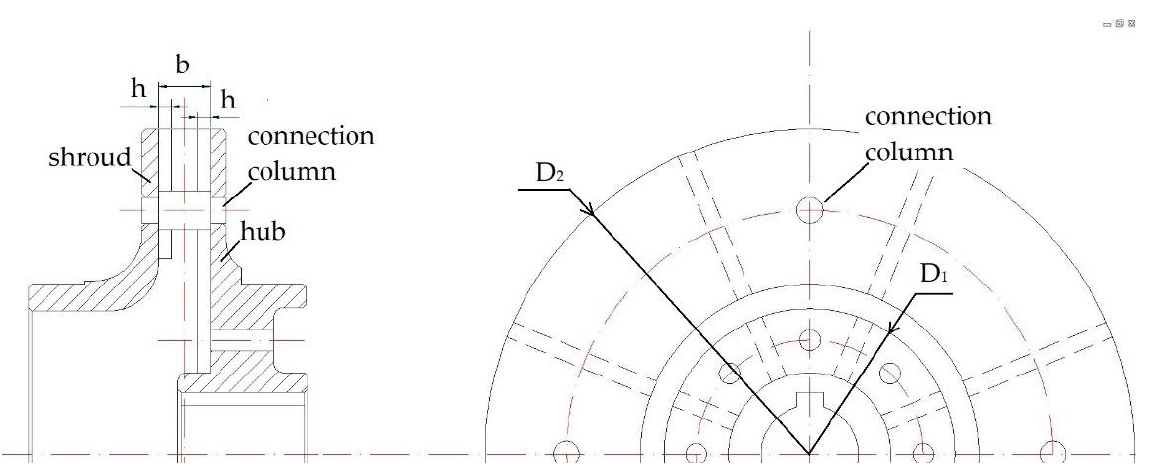
Figure 7. Diagram of the impeller internal main structure and dimensions of the disc pump.